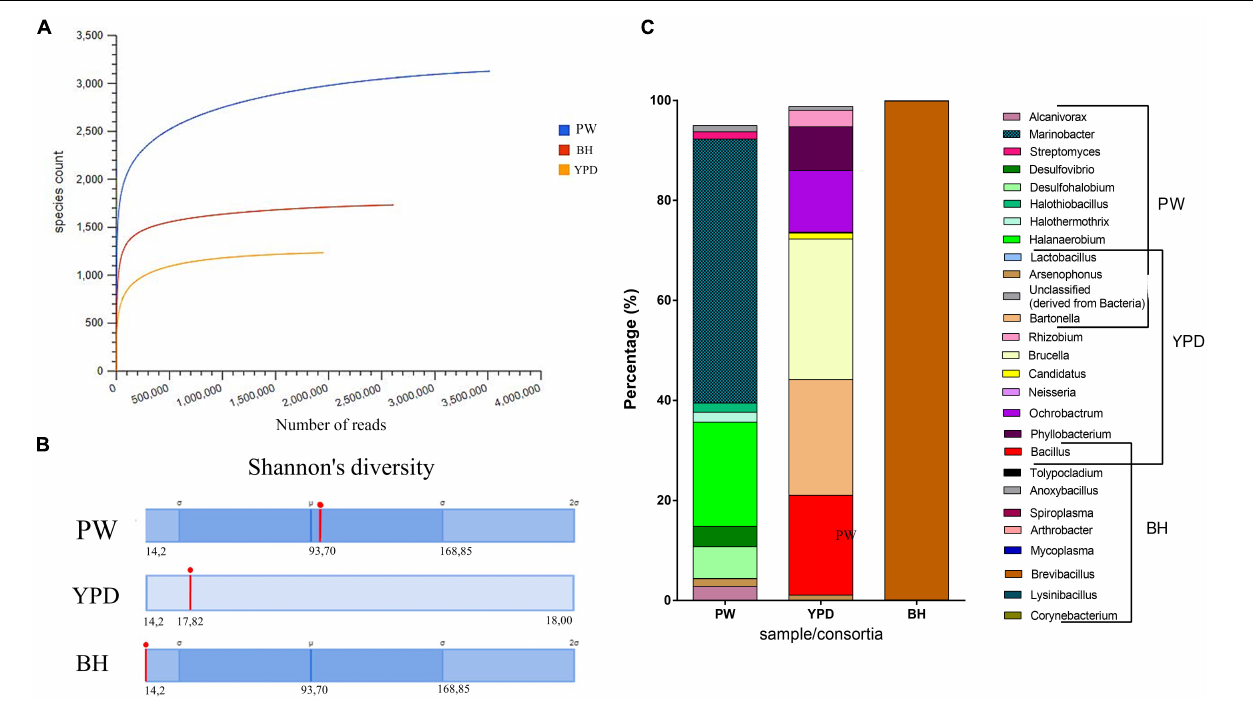
FIGURE 2 | Taxonomic diversity of the samples. (A) Rarefaction curve of samples sequenced by the shotgun metagenomics analysis method and analyzed using MG-RAST. Blue curve = production water (PW); red curve = BH consortium; and yellow curve = YPD consortium. (B) Comparison of the Shannon’s diversity indices (red line) between the three sequenced samples. Automatic annotation performed by the MG-RAST pipeline. (C) Most abundant genera identified in the production water (PW), YPD consortium, and BH consortium.